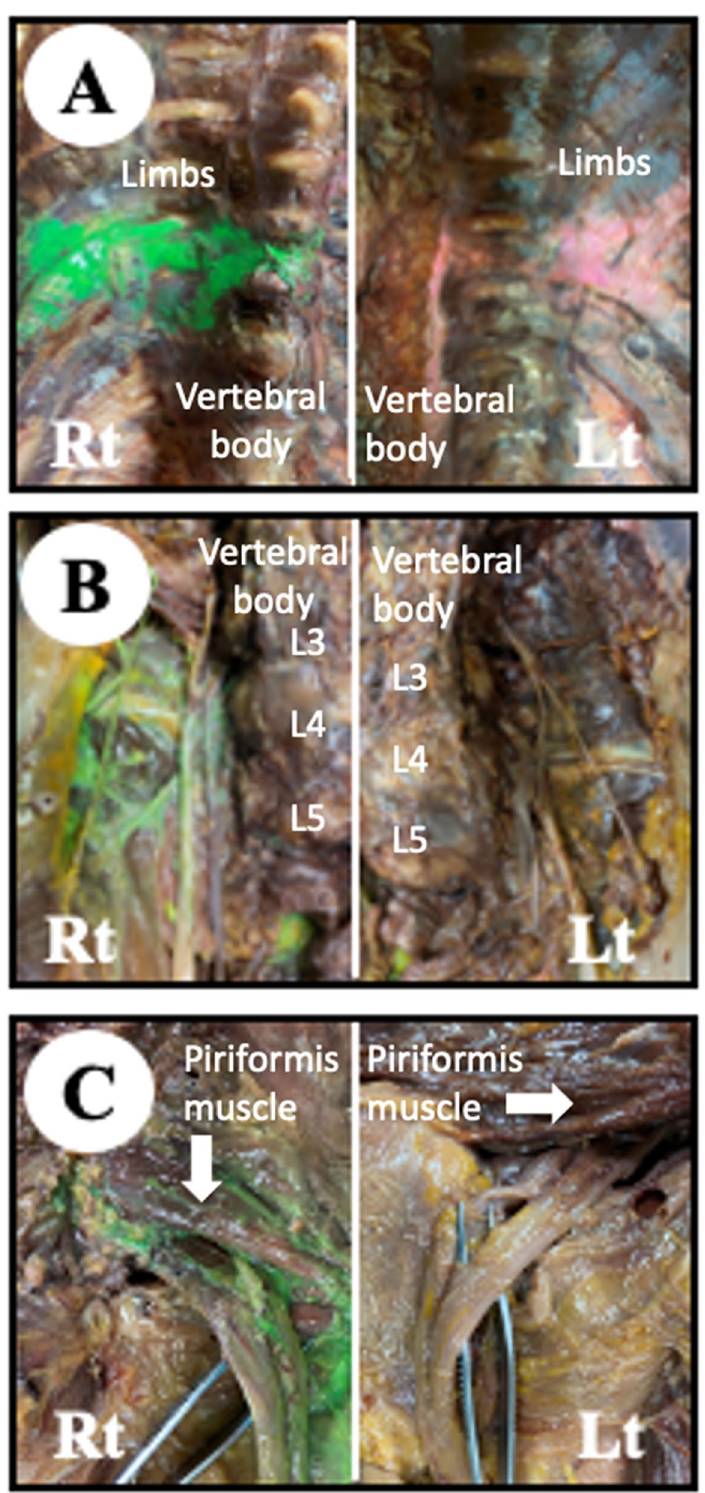
Figure 4. Dissected region in the cadaver. Paint injected during the deep nerve block at right- or left-side of a cadaver are green or pink, respectively. Pink stain at the left-side lumbar plexus block ( B . Lt) and sciatic nerve block ( C , Lt) are undetermined due to weak and blurred stain in connective tissue over the nerves. ( A ) Paravertebral block, ( B ) lumbar plexus block, ( C ) sciatic nerve block. Rt right-side of the cadaver, Lt left-side of the